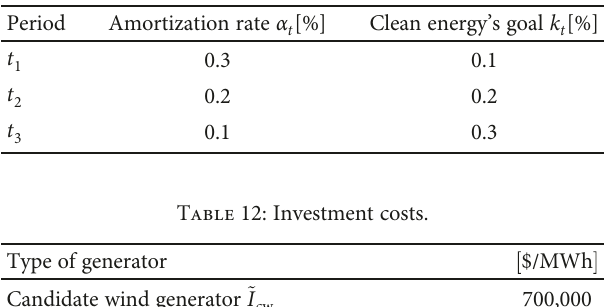
Table 11: Amortization rate per period and clean energy ’ s goal per period.